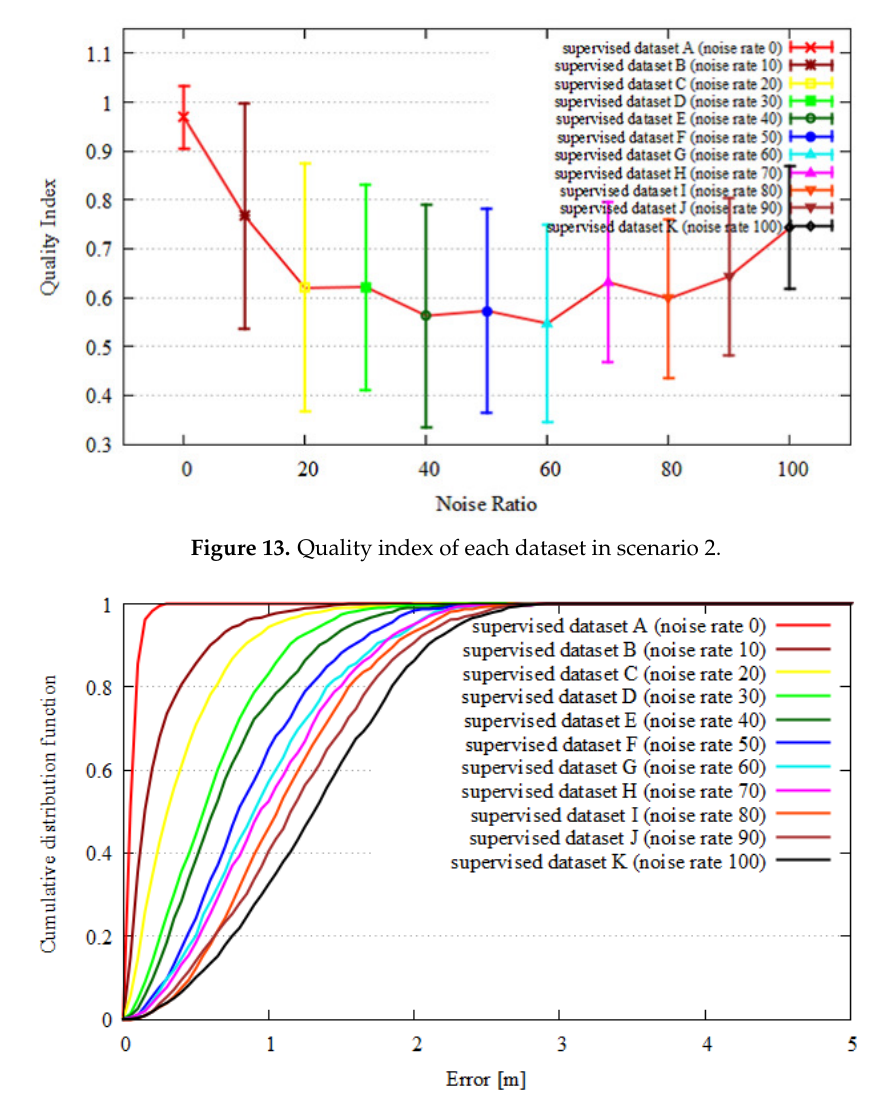
Figure 14. Test error of each dataset in scenario 1.